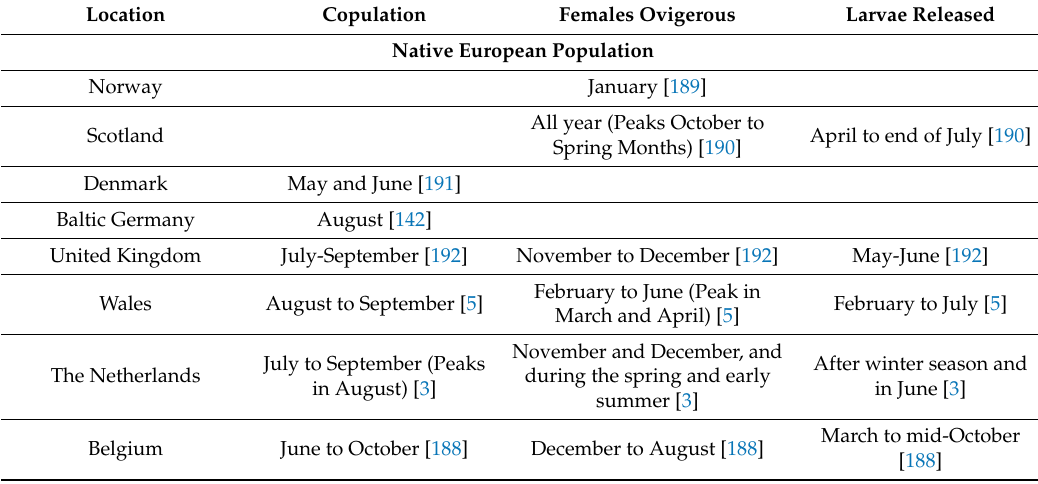
Table 1. Seasonality of C. maenas reproductive events in di ff erent populations. Empty cells indicate no data are available for that